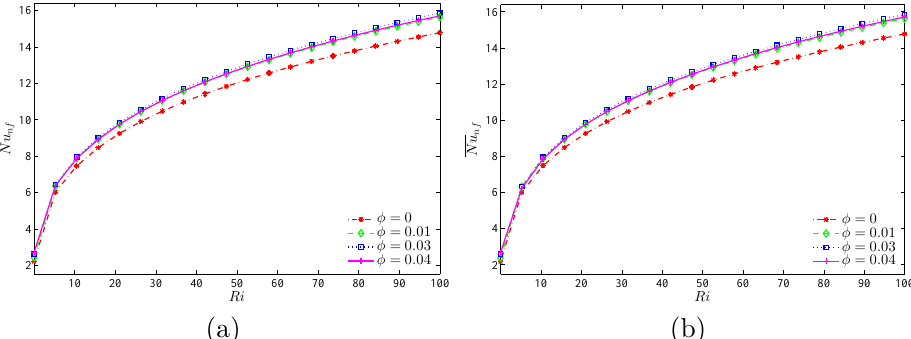
Figure 11. Variations of the average Nusselt number with Ri for different φ for ( a ) Case 1 ( Ω ) and ( b ) Case 2 ( − Ω ) at N = 3 and R = 0.15.